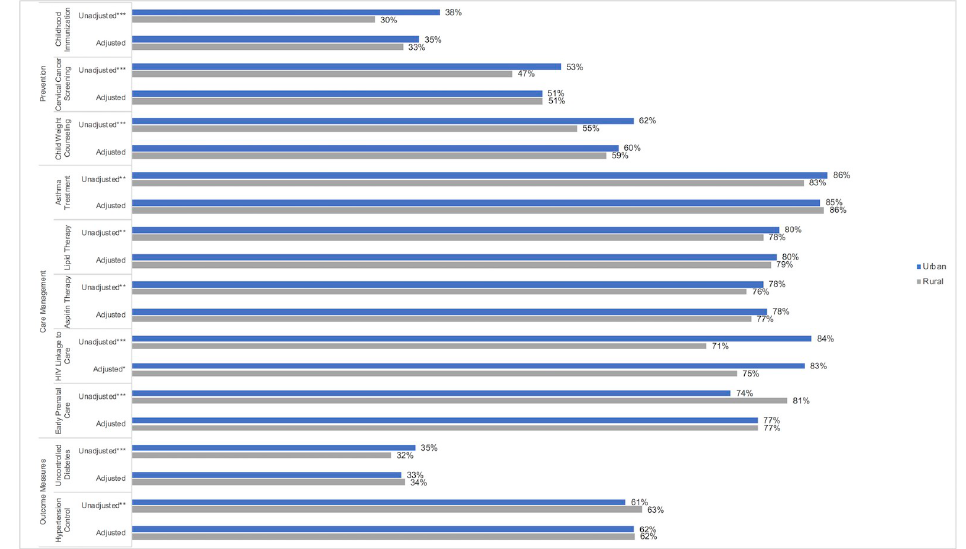
Fig 1. Unadjusted and adjusted predicted probabilities for health center quality indicators by urban and rural status. Unadjusted analyses involved comparing urban and rural health center status using t-tests. Adjusted analyses were conducted using fractional outcome regression models using the logit distribution. Statistically significant at � p < 0.05; �� p < 0.01; ��� p < 0.001 comparing urban vs.